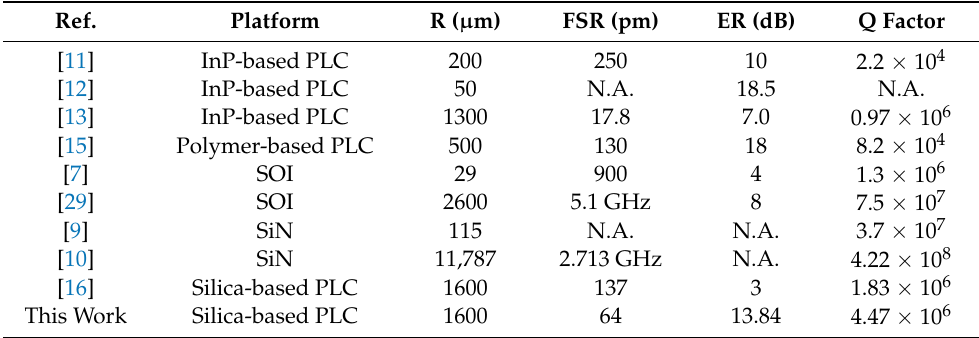
Table 1. Comparison of high-Q